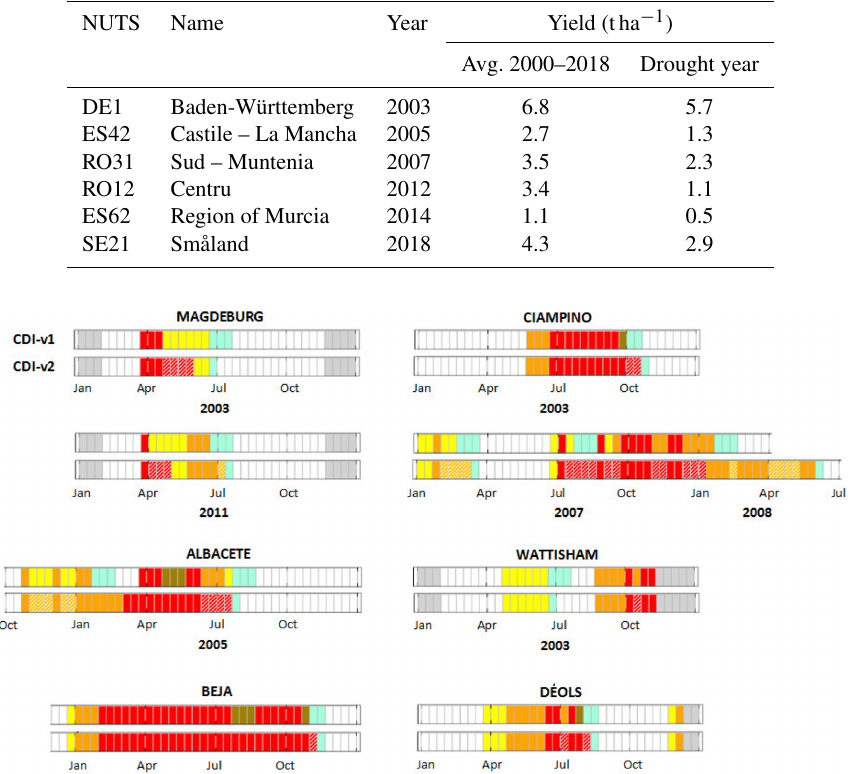
Table 1. Cereals (including rice) yield (tha − 1 ) data for different NUTS regions as derived from the Eurostat database. The column “Avg. 2000–2018” reports the average yield during the whole period, whereas the column “Drought year” reports the actual yield for the drought year specified in the “Year” column.